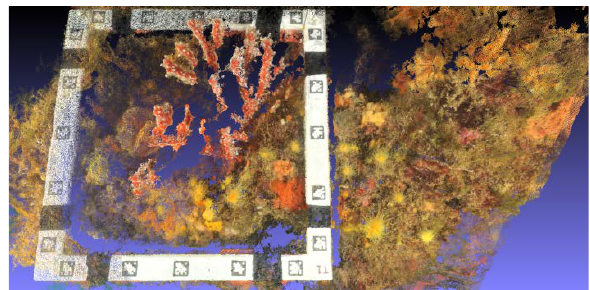
Figure 11. Dense cloud of point measured automatically to check the manual